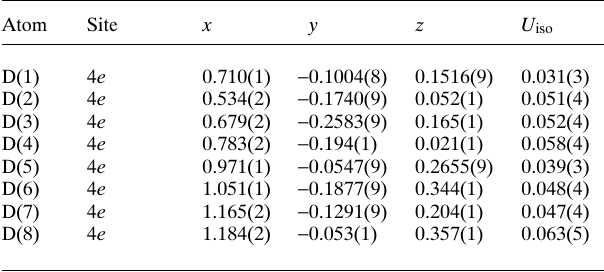
Table 2. Atomic coordinates and displacement parameters (in Å 2 )